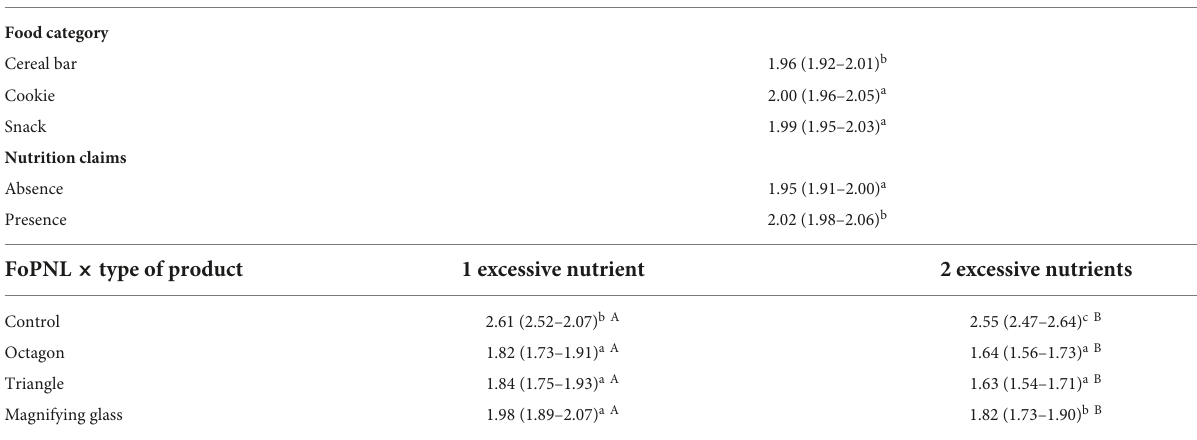
TABLE 5 Average healthfulness perception scores by FoPNL (control, octagon, triangle, and magnifying glass), food category (cereal bar, cookie, and snack), type of product (containing 1 and 2 excessive nutrients), nutrition claims (absence and presence), and their